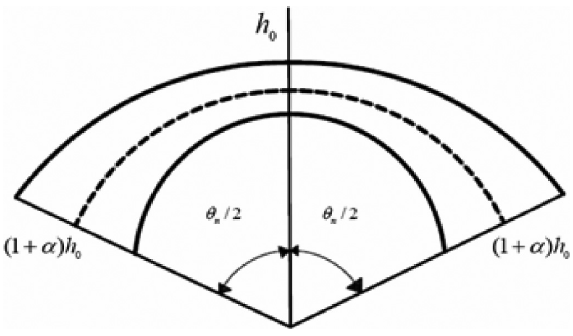
Fig. 9. Symmetric tapered arch with linearly varying